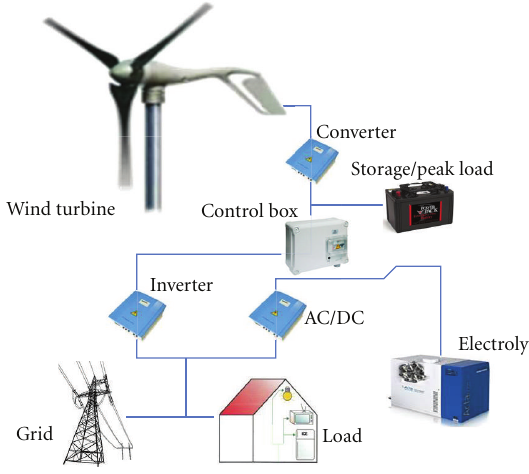
Figure 2: NanoCatGeo microgrid developed at University of Pisa.